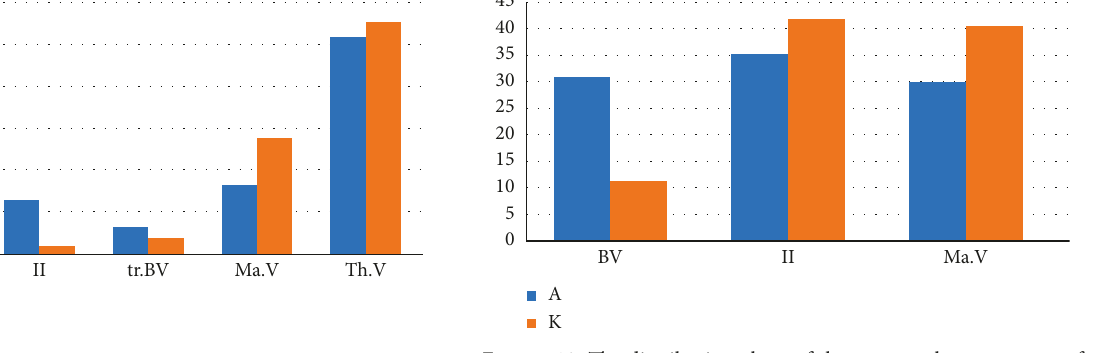
Figure 18: The distribution chart of the structural components of regenerated cancellous bone tissue 2 weeks after the formation of a bone defect and introduction of calcium hydroxide suspension (both, with and without nanodispersed cerium dioxide). Where nBv is the relative volume of the newly formed bone tissue (%), tr.BV is the relative volume of the lamellar bone tissue (old) (%), II is the relative volume of the granulation tissue (%), Ma.V is the relative volume of the bone marrow (%), and Th.V is the relative volume of the tooth and periodontal tissues (%) (A—with cerium dioxide and K—without cerium dioxide).